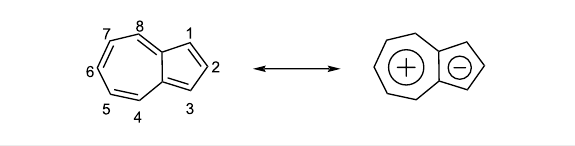
Figure 1: Chemical structure, numbering scheme, and resonance form of